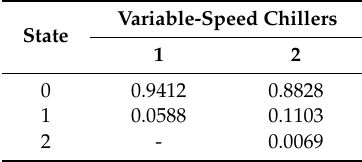
Table 2. Probability distribution of steady states of variable-speed chillers.